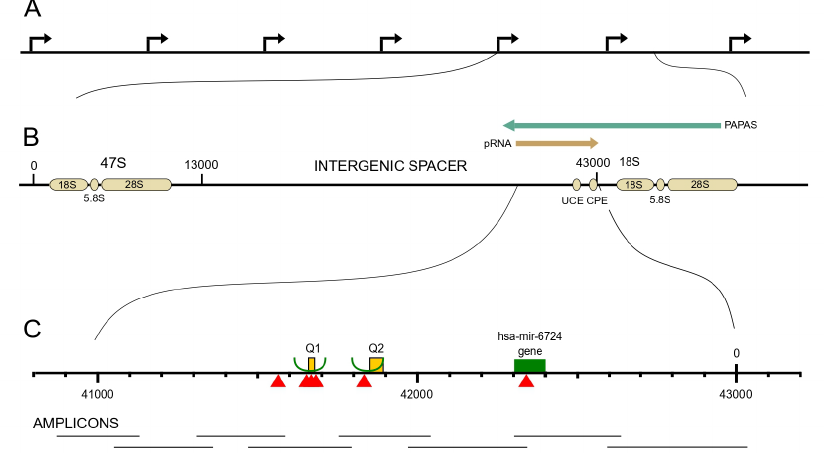
Figure 1. The structure of rDNA locus and the variants which appeared with different frequencies in the methylated and non-methylated DNA. ( A ) Cluster of repetitive rDNA units. ( B ) Details of one unit including genes encoding 18S, 5.8S, and 28S ribosomal RNAs; intergenic spacer (IGS); pro- moter with upstream control element (UCE) and core promotor element (CPE); promoter and pre- rRNA antisense (PAPAS) and promoter-associated RNA (pRNA). ( C ) The regulatory region up- stream of the transcription start site (URR); the fragments amplified by PCR are shown below. Var- iants with significant difference of methylated and non-methylated state are indicated by red ar- rowheads. Yellow rectangles represent regions of simple repeats Q1 and Q2. The green rectangle corresponds to the gene encoding hsa-mir-6724. Two green semicircles indicate regions correspond- ing to miRs produced outside the rDNA locus. Among the variants that appeared with the frequency >5%, we found totally: 33 SNVs, 5 simple inserts and deletes (indels), and a number of variously sized (from 1 to 34 bp) deletions in two regions of simple repeats (CCCT)n: Q1 (41667–41686; n = 5) and Q2 (41842–41877; n = 9), both flanked by CT and GC upstream and downstream, respectively. One SNV and one insert (at 41006 and 41008) belonged to the Alu element; one SNV at 42945 is situated between the UCE and CPE of the rDNA promoter. In all, 21 variants occurred with low frequency (5–30%). In addition, 13 variants seem to be a specific feature of the studied cell line, since they appeared in 70–100% reads. Moreover, three variants were found in 30–70% reads and, accordingly, the respective positions may be called hot spots of variability.